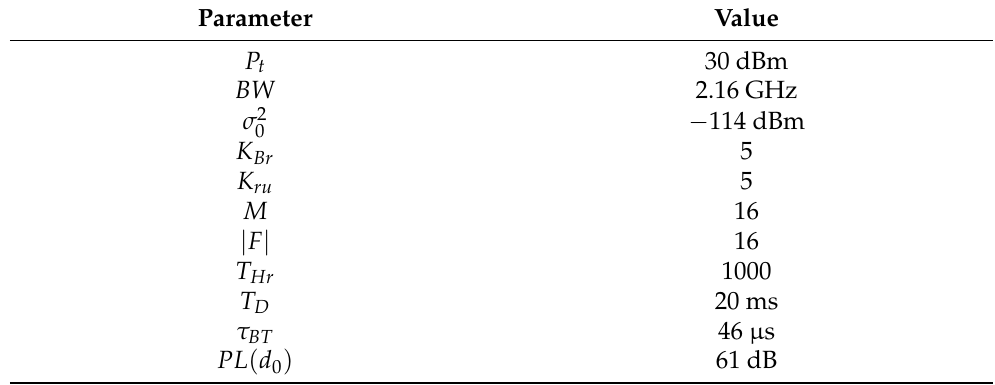
Table 1 states other important simulation parameters. Table 1. Simulation parameters.